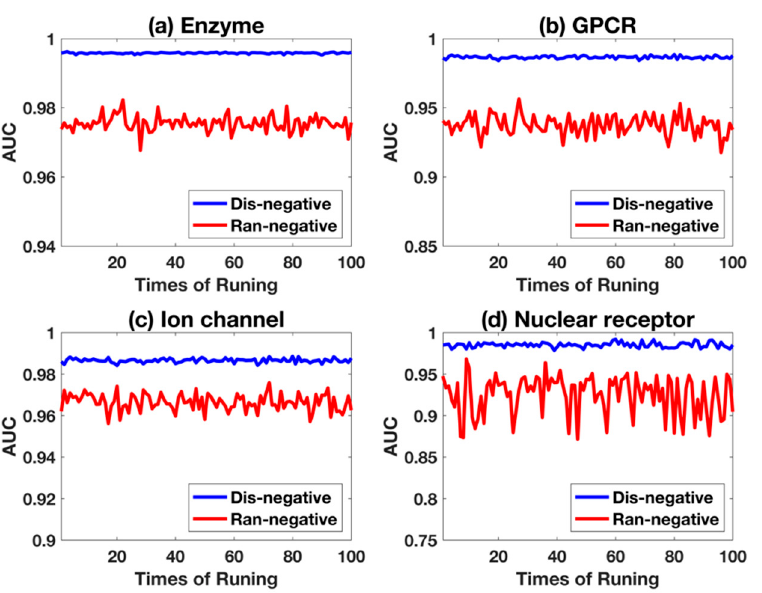
Figure 5. The robustness of two negative sampling methods. Ran-negative and Dis-negative indicate the experimental setting for negative sampling based on random and distance in 100-times repetition, respectively.